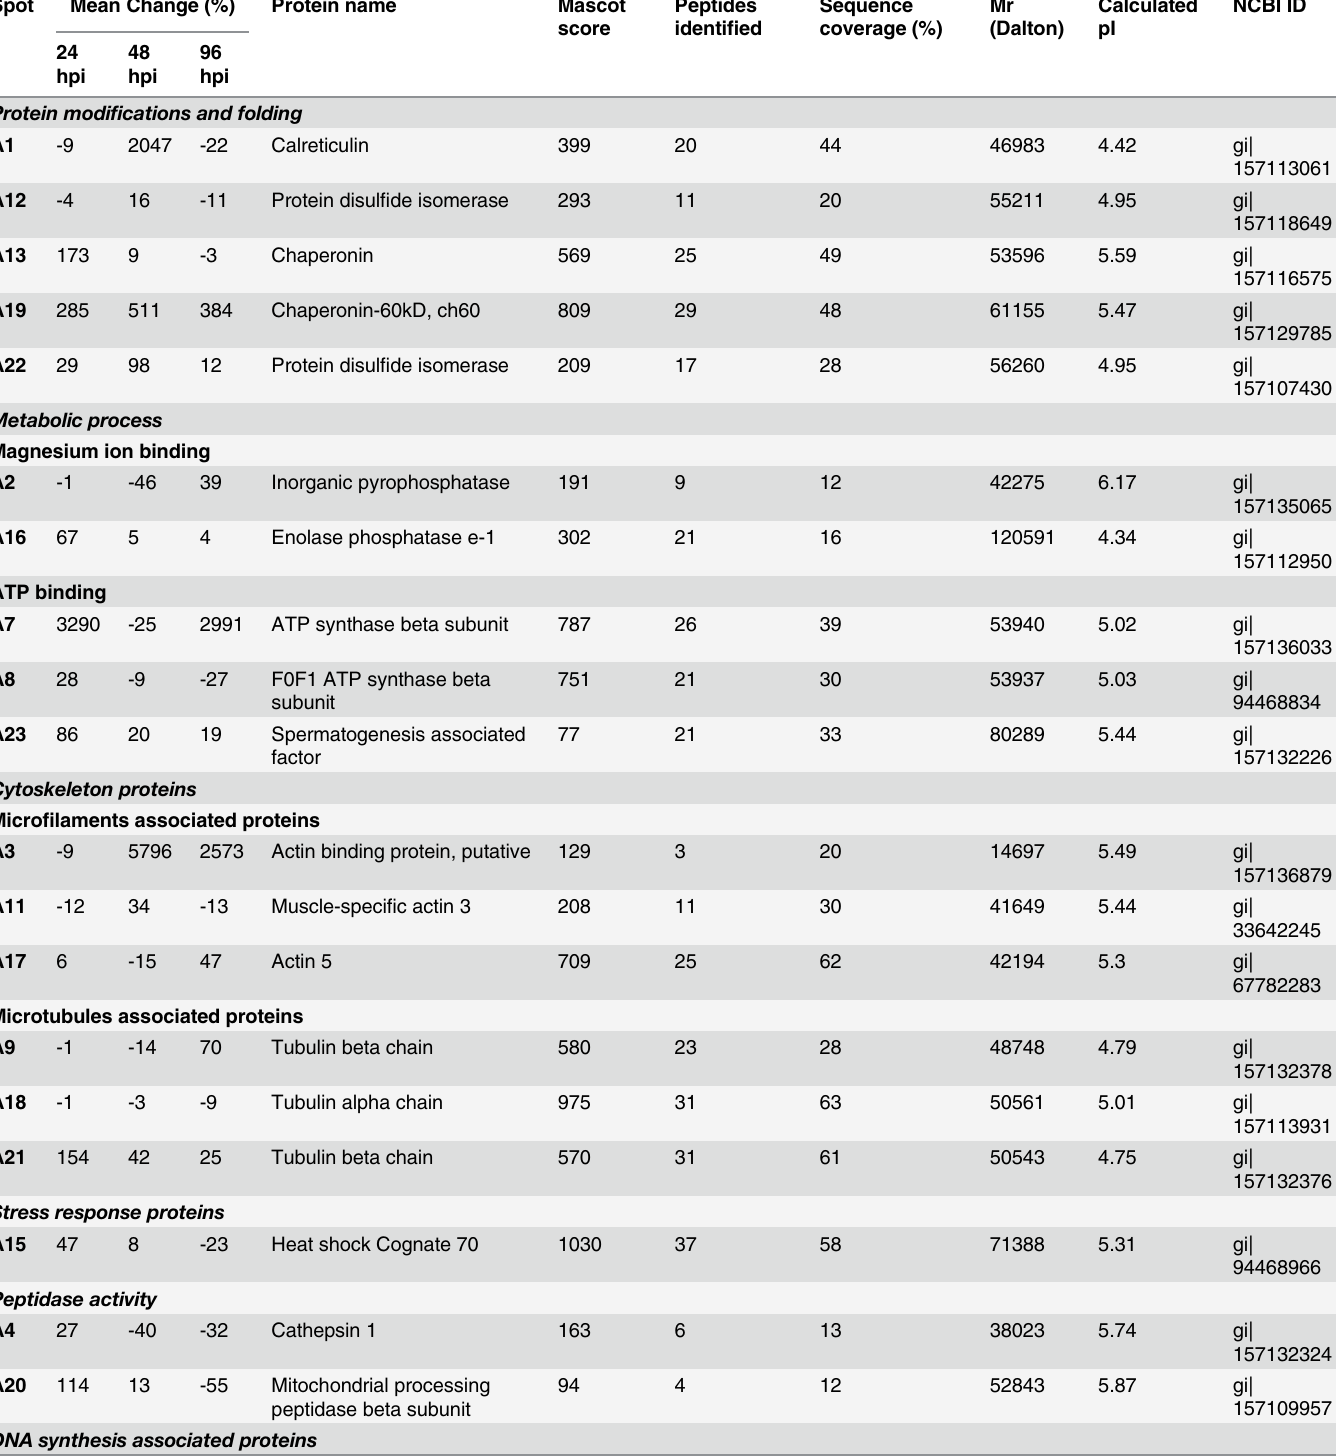
Table 1. Mean change in spot intensities and mass spectrometry data of 23 differentially regulated proteins from CHIKV-infected C6/36 cells at M.O.I. 10. Spot Mean Change (%)